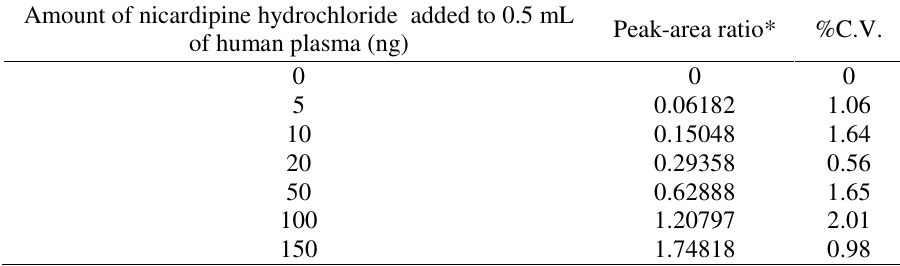
Table 1 . Calibration and precision of the HPLC assay Amount of nicardipine hydrochloride added to 0.5 mL